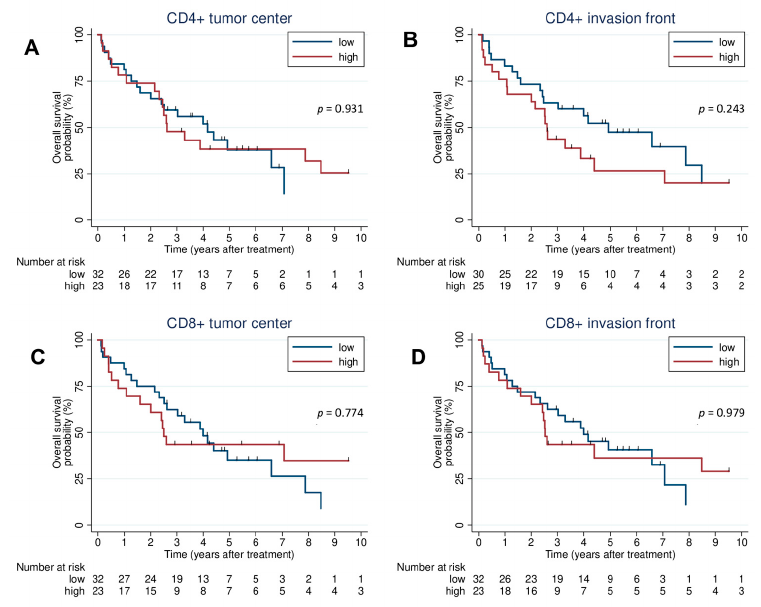
Figure 2. Survival analysis. Kaplan–Meier plots of OS for CD4+ tumor center ( A ), CD4+ invasion front ( B ), CD8+ tumor center ( C ), CD8+ invasion front ( D ). OS: overall survival.